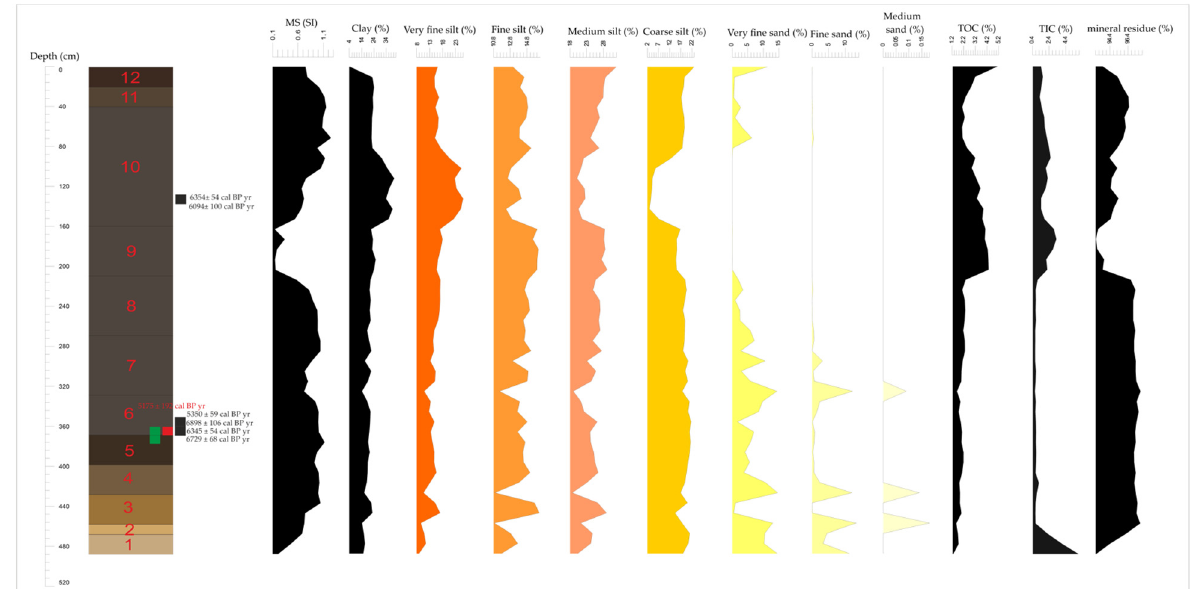
Figure 7. The strata of the central borehole of 490 cm of the Császárné Mound. Besides the results of magnetic susceptibility measurements, grain size distribution and LOI measurements on the samples of 490 cm borehole of Császárné Mound. Red numbers: (1). Yellowish-gray sandy layer, (2). Grayish-yellow sandy layer, (3). Yellowish-brown loessy layer, (4). Buried soil layer B horizon, (5). Buried soil layer A horizon, (6). First construction layer of the mound (7), The compact- structured, trampled section of the first construction layer, (8). Second construction layer of the mound (9). The compact-structured, trampled section of the second construction layer, (10). First construction layer of the mound, (11). Recent surface soil B horizon, (12). Recent surface soil A horizon. The different layers are colored according to the RGB color of the described Munsell color categories. Black squares: cal BP yr age of soil OM. Red square: cal BP yr age of the Unio shell fragment. Green squares: The depth of the samples used for pollen analysis. 6. Conclusions The Császárné Mound is located in the Danube-Tisza Interfluve region of the Hungarian Great Plain. The investigation of the mound facilitated the reconstruction of the former local environment before and during the construction of the kurgan and its effect on the local environment. The analysis of the kurgan—which is based on macroscopic analyses, loss on ignition, magnetic susceptibility (MS), grain size composition examinations of the samples from a drilling section of 4.9 m—suggest three different construction phases. Based on our data, the upper layers of the original meadow Chernozem soil were used for the construction, which developed the loessy sediment that accumulated on former river bank sediments.